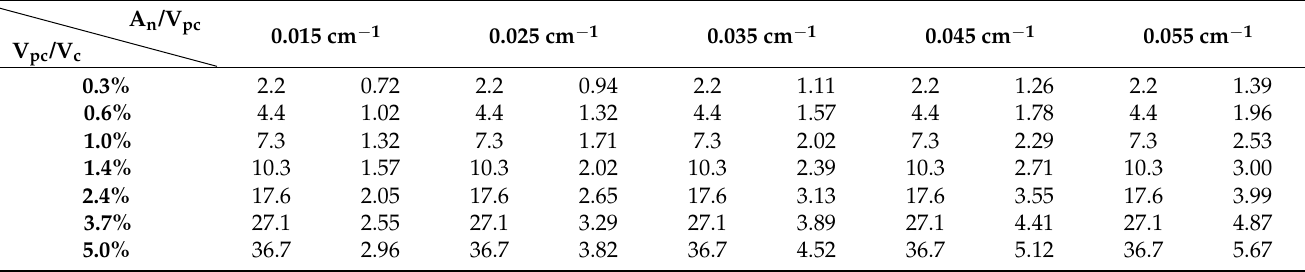
Table 2. Test grid for optimal design of